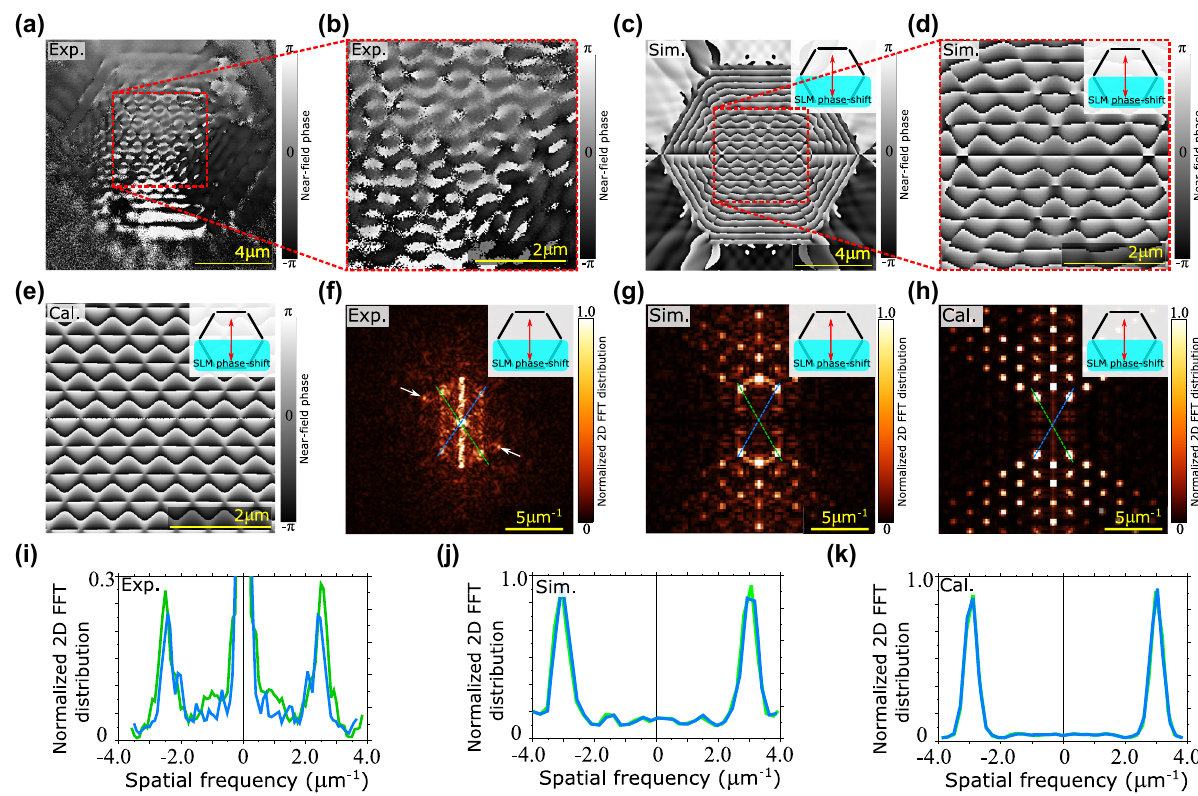
Figure 4: Near-field phase distribution on hexagonal SPID. Hexagonal SPID with three upper slits producing the OBJ wave and three bottom slits producing the REF wave: Phase distribution reconstructed from the experiment (a) with detail (b), numerical calculations (c) with detail (d), and the analytical model (e). (f)–(h) FT of phase distribution shown in (b), (d), (e), respectively. (i)–(k) Profiles along the colour-matched dashed lines in (f)–(h), respectively, show the most frequent modulations from the source